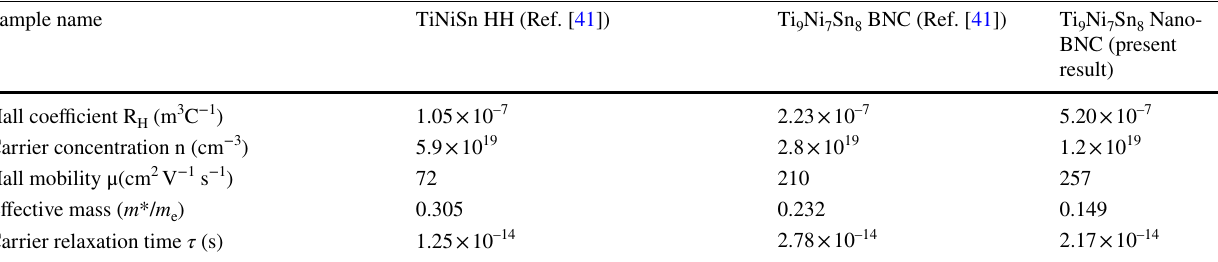
Table 1 Room-temperature physical parameters such as lattice and free electron rest mass m e of Nano-BNC samples and compared with HH, BNC for understanding of nanostructuring effect parameter (a), Hall coefficient R H , carrier concentration n, Hall mobility μ, carrier effective mass m*, and carrier relaxation time τ TiNiSn HH (Ref.